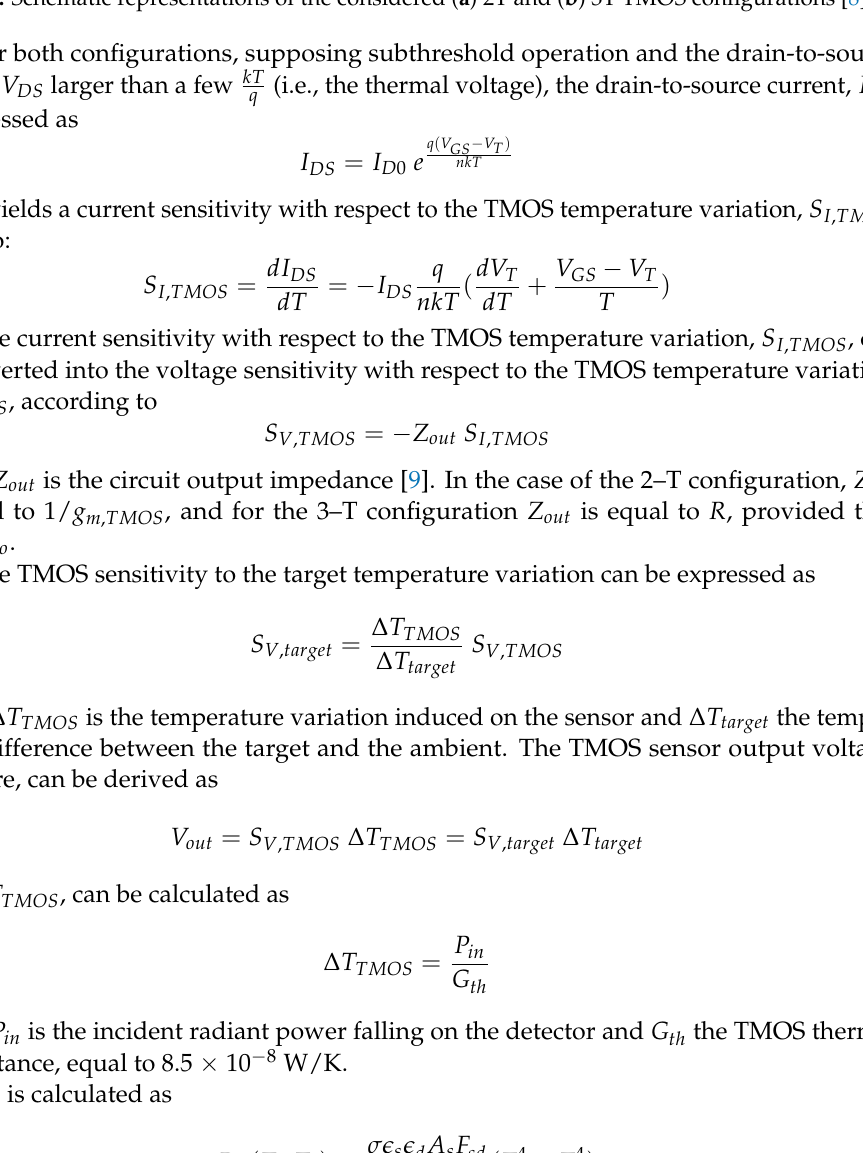
Figure 3. Schematic representations of the considered ( a ) 2T and ( b ) 3T TMOS configurations